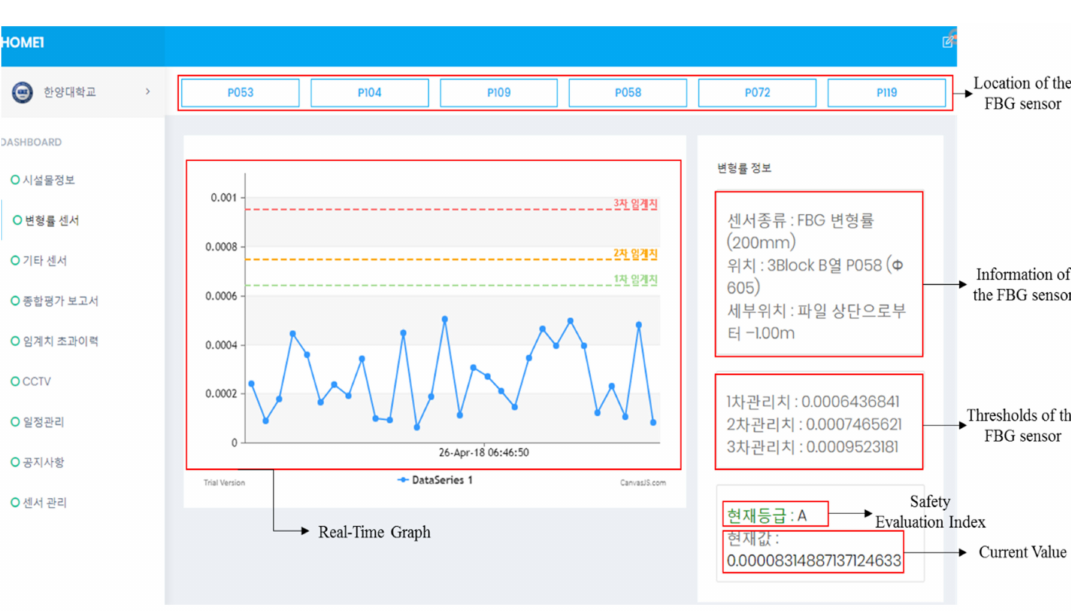
Figure 11. A screenshot of the web server that displays the measured